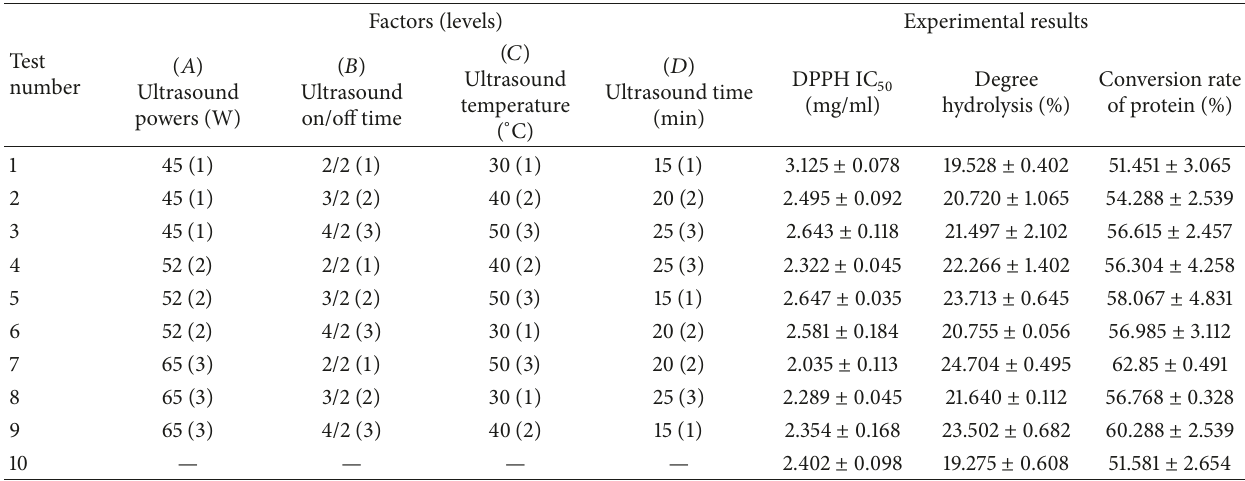
Table 1: Factors and levels of the orthogonal design L 9 (3 4 ) of ultrasound pretreatment process and experimental results for corn protein hydrolysis ( 𝑛 = 3 , mean ± SD); number 10 represents traditional hydrolysis.